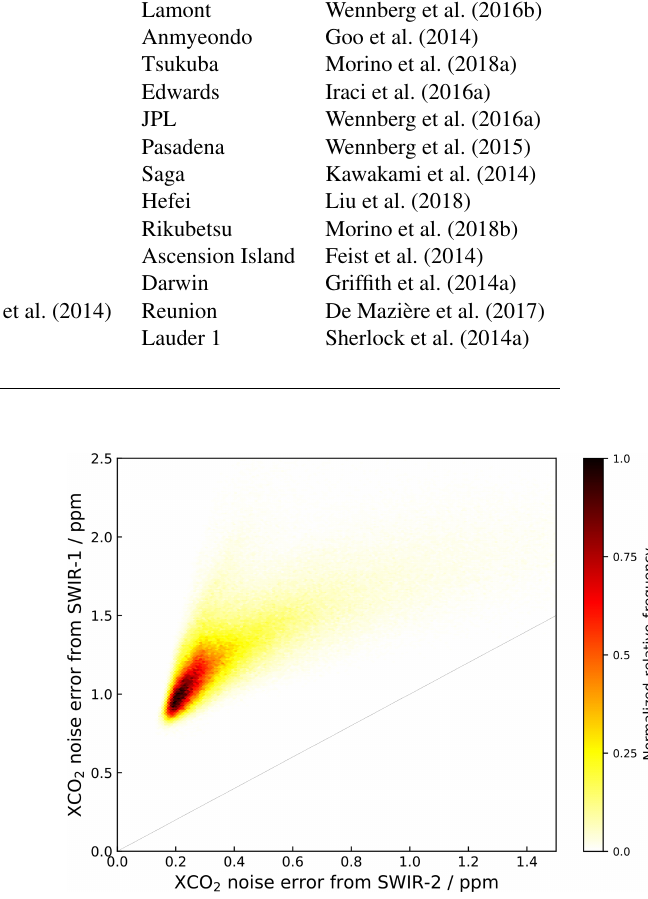
Figure 12. XCO 2 noise errors for SWIR-1 (ordinate) and SWIR-2 (abscissa). The grey line indicates the 1 : 1 correlation. Color shad- ing encodes the relative occurrence of data